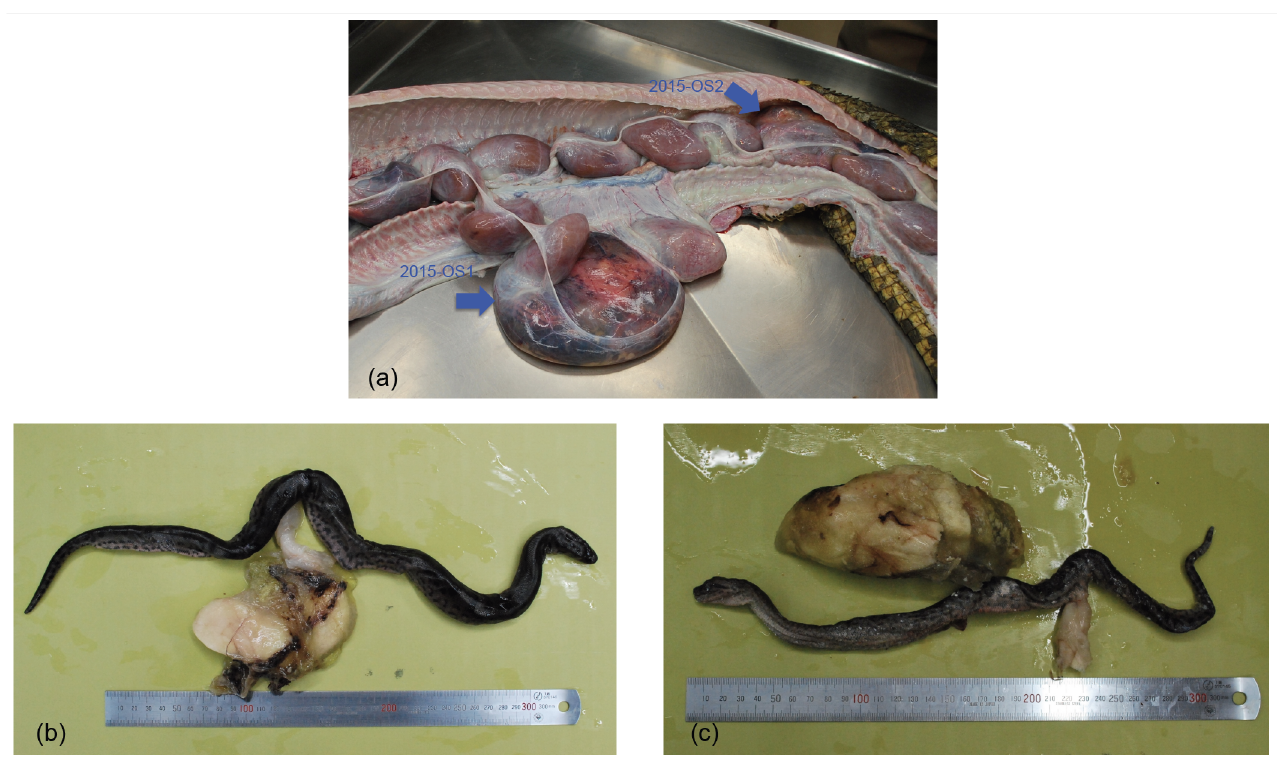
Fig 1. Neonates found in the oviduct of the focal mother (Emu-01) that had been isolated from other snakes for seven years. a. Two fully developedneonates, 2015-OS1 and 2015-OS2 (shown with arrows) were found in the oviduct as well as multiple undeveloped eggs. Unfortunately, both neonateswere found dead. b. 2015-OS1 was a fully developedfemale neonate.c. 2015-OS2 was also a fully developedfemale neonate.